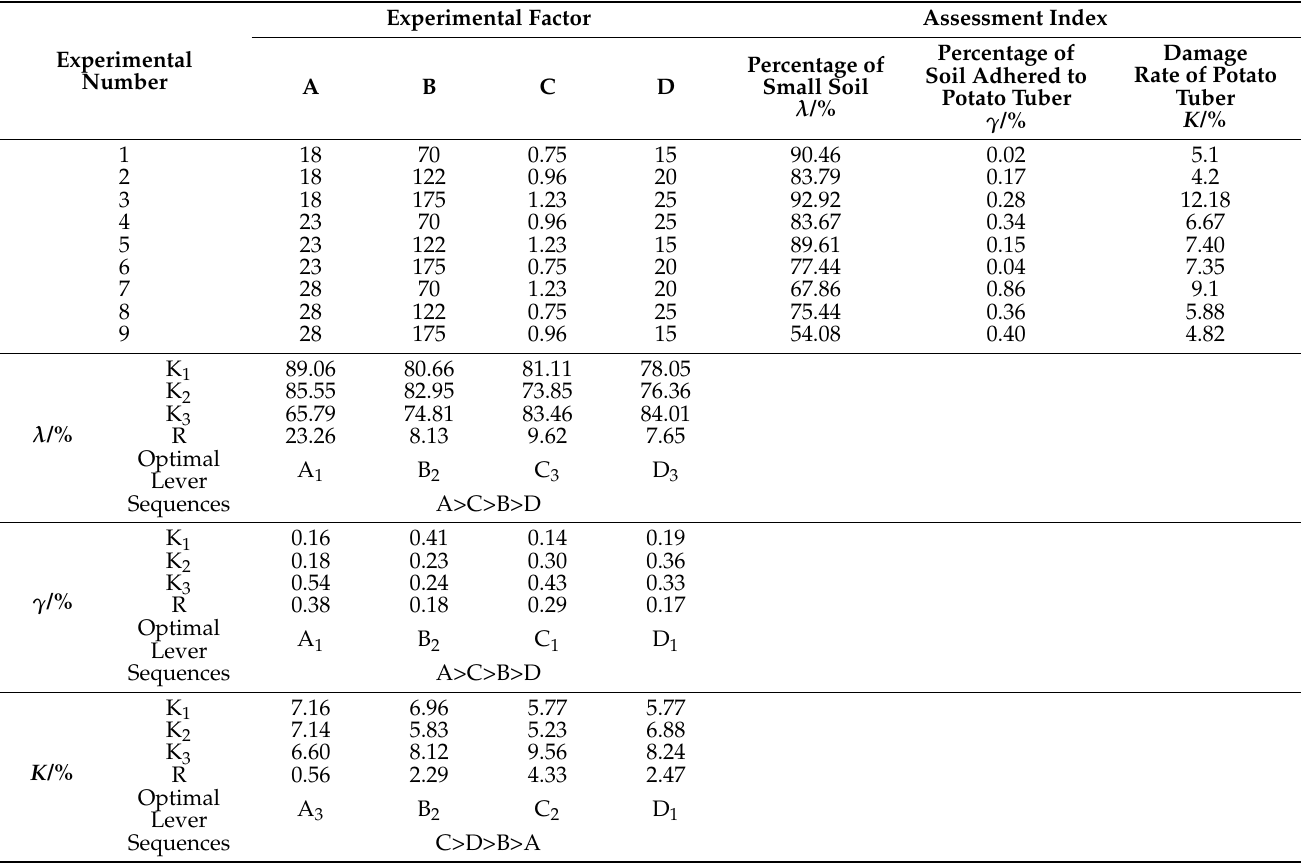
Table 3. Results of orthogonal test and range